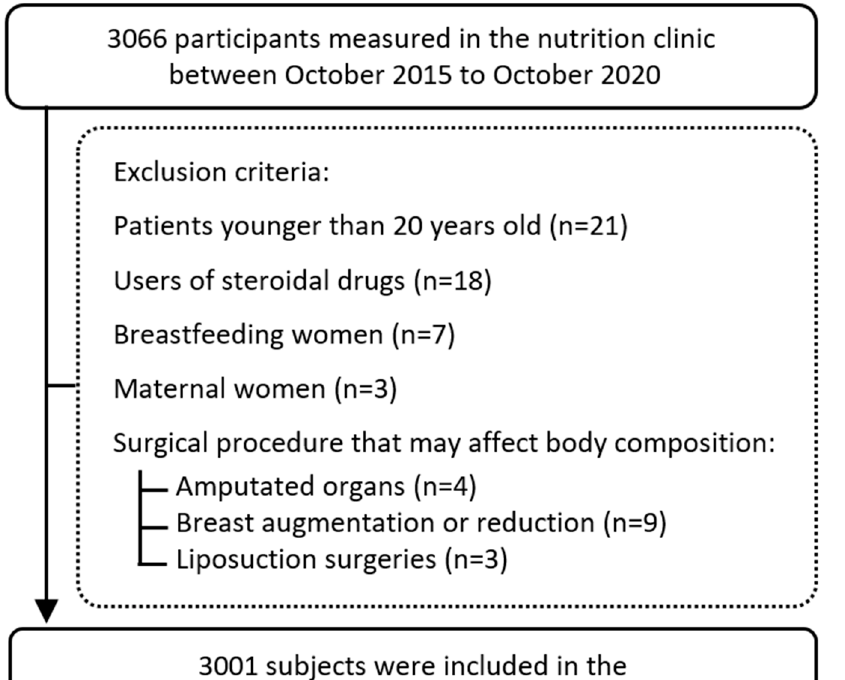
Figure 1. Study flow chart.